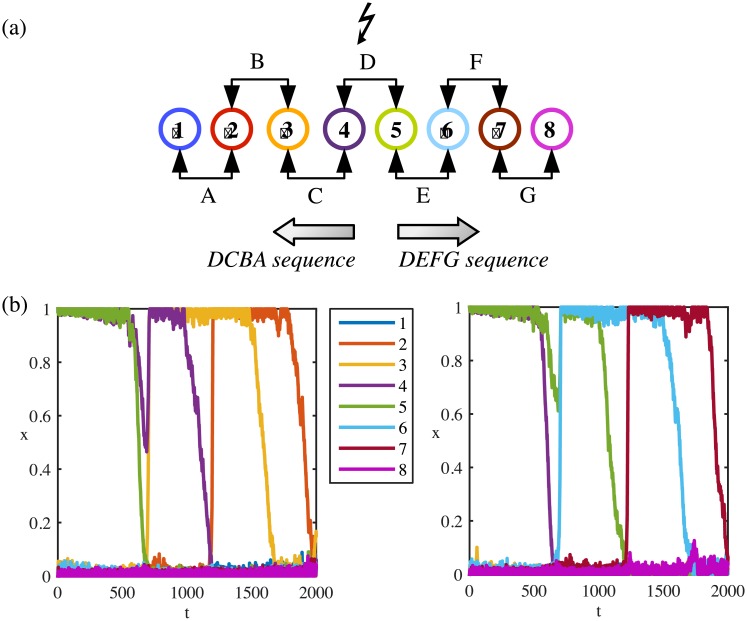
Directional sequences of a midpoint stimulus-driven system.(a) Each numbered circle represents a unit. Consecutive neurons encode a pattern. Except for x1 and x8, each unit participates in the encoding for two patterns. When the system initialised from the pattern D, it follows either the “DCBA” or “DEFG” sequence. (b) Left panel: System initialised from the pattern D follows the “DCBA” sequence until the pattern B. Right panel: System initialised from the pattern D follows “DEFG” sequence until the pattern F. The same colour code is used to represent units’ indices in (a) and (b). Parameters: μ = 0.414, λ = 0.51, I = 0, ρ = 1.8, τr = 900, η = 0.02.